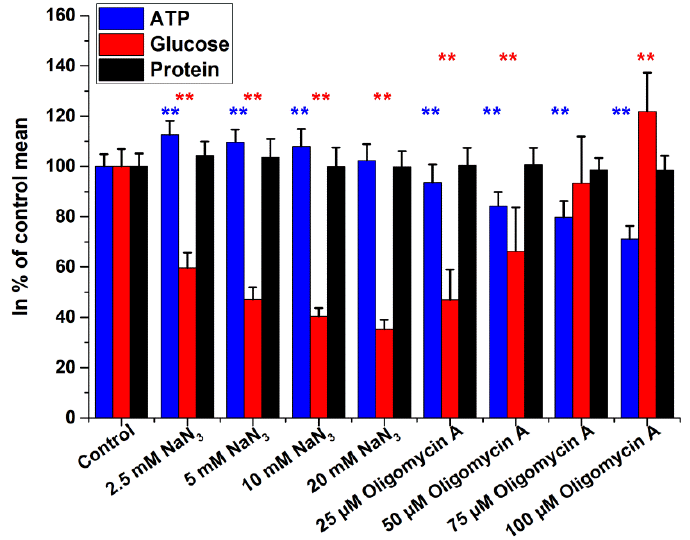
Figure 6. Intracellular glucose, ATP, and protein levels of HepG2 cells after 4 h treatment with inhibitors of terminal oxidation. Data are expressed as % of control. Bars represent mean ± SD of six independent experiments (* p < 0.05, ** p < 0.01 compared with controls).